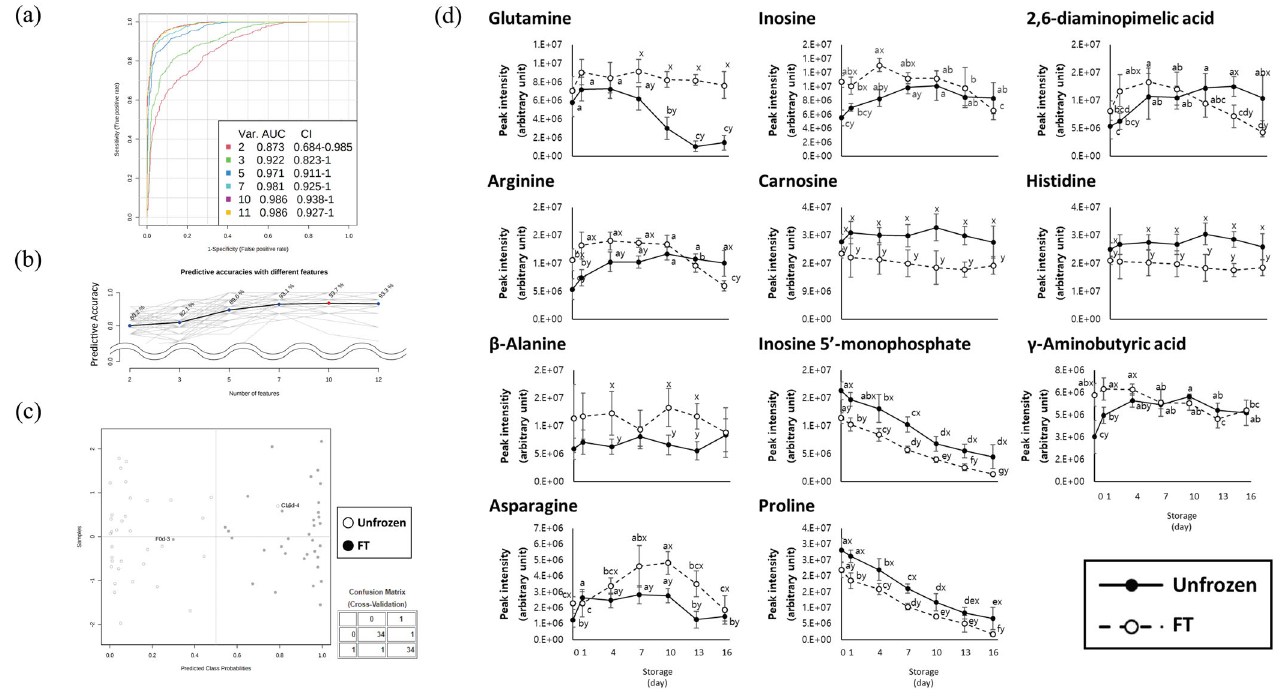
Fig. 3 Key metabolites for discrimination of unfrozen and frozen/thawed chicken meat. Multivariate area under the curve (AUC) analysis ( a ), predictive accuracies with different features ( b ), predicted class probabilities ( c ), and changes over storage time ( d ) made with 11 selected metabolites from two-way analysis of variance (ANOVA). a – f Different letters in the same group indicate a signi fi cant difference ( p < 0.05). x – y Different lettersin the same storage day indicate a signi fi cant difference ( p <